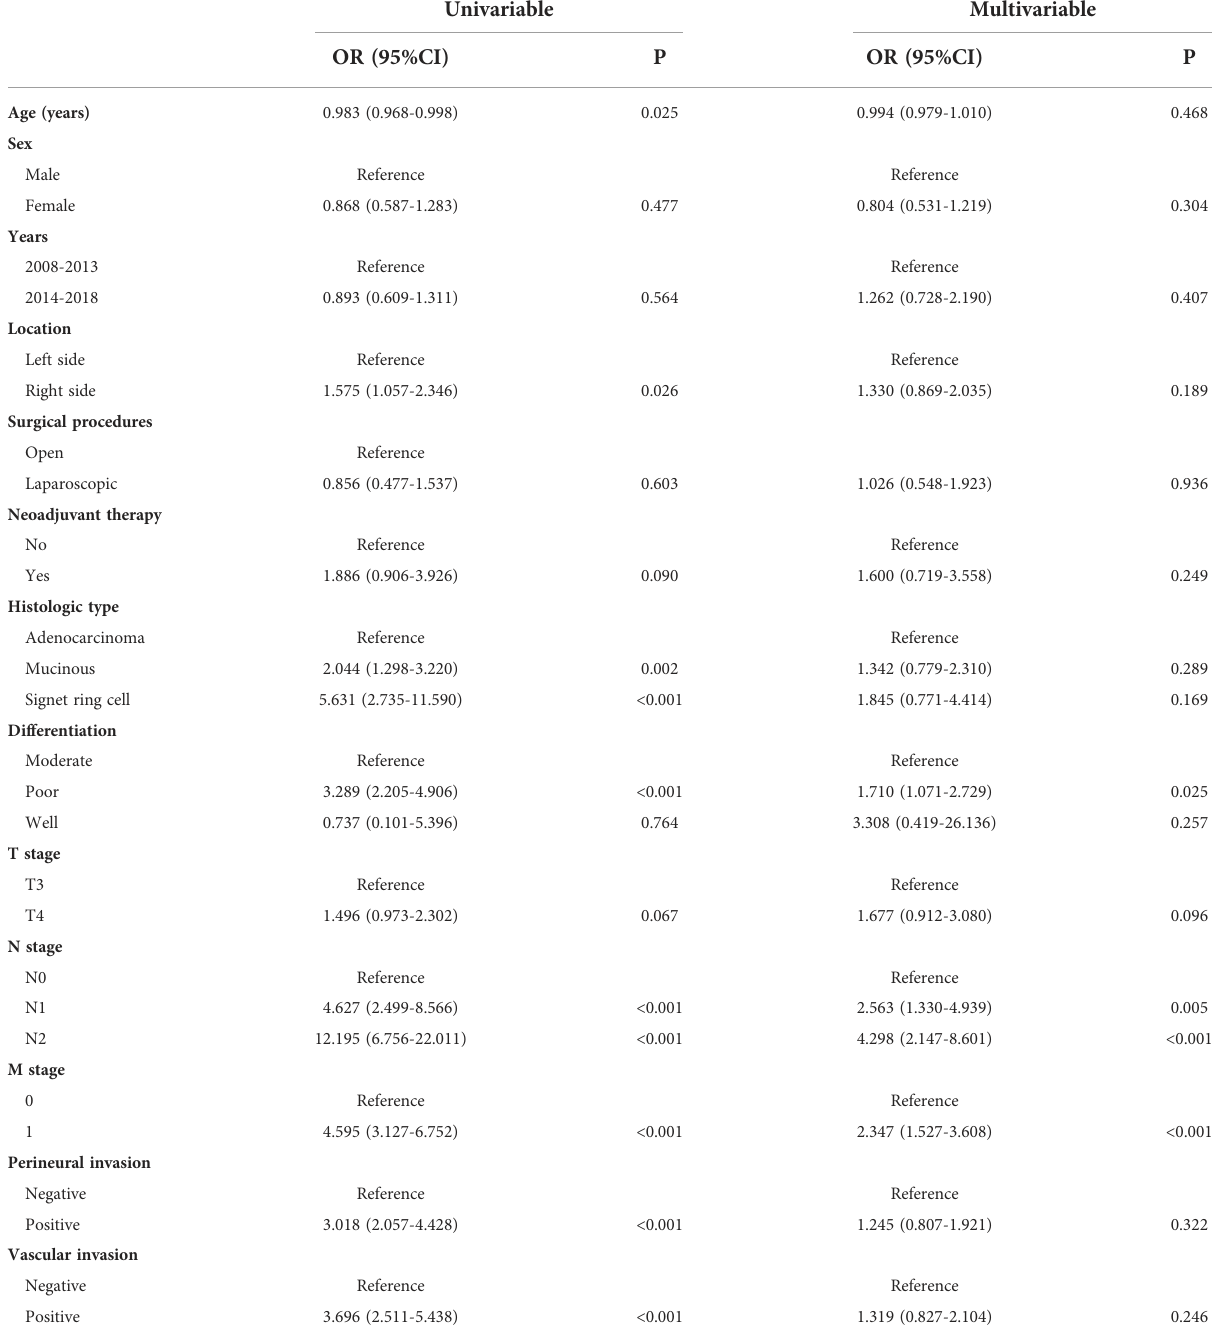
TABLE 2 Univariable and multivariable logistic regression model for factors predictive of positive CRM after colon cancer